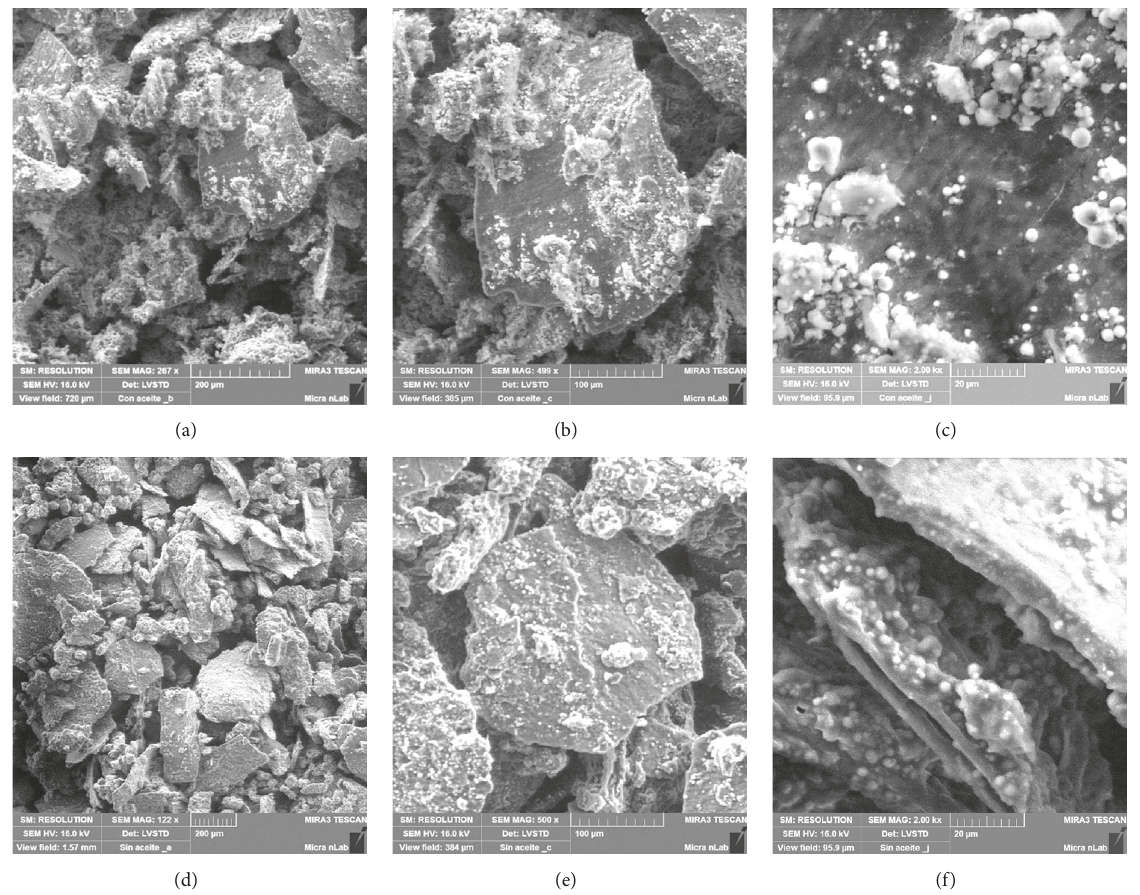
Figure 4: Morphological aspects of the rice bran particles: (a)–(c) nondefatted and (d)–(f)